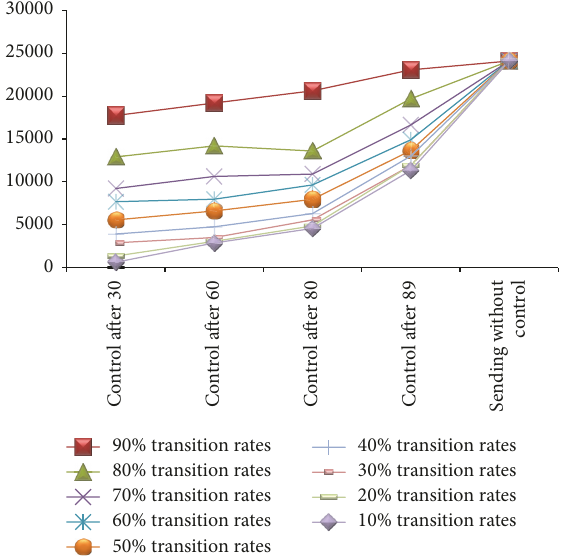
Figure 9: User transition rate, trigger point, and accumulated sending.